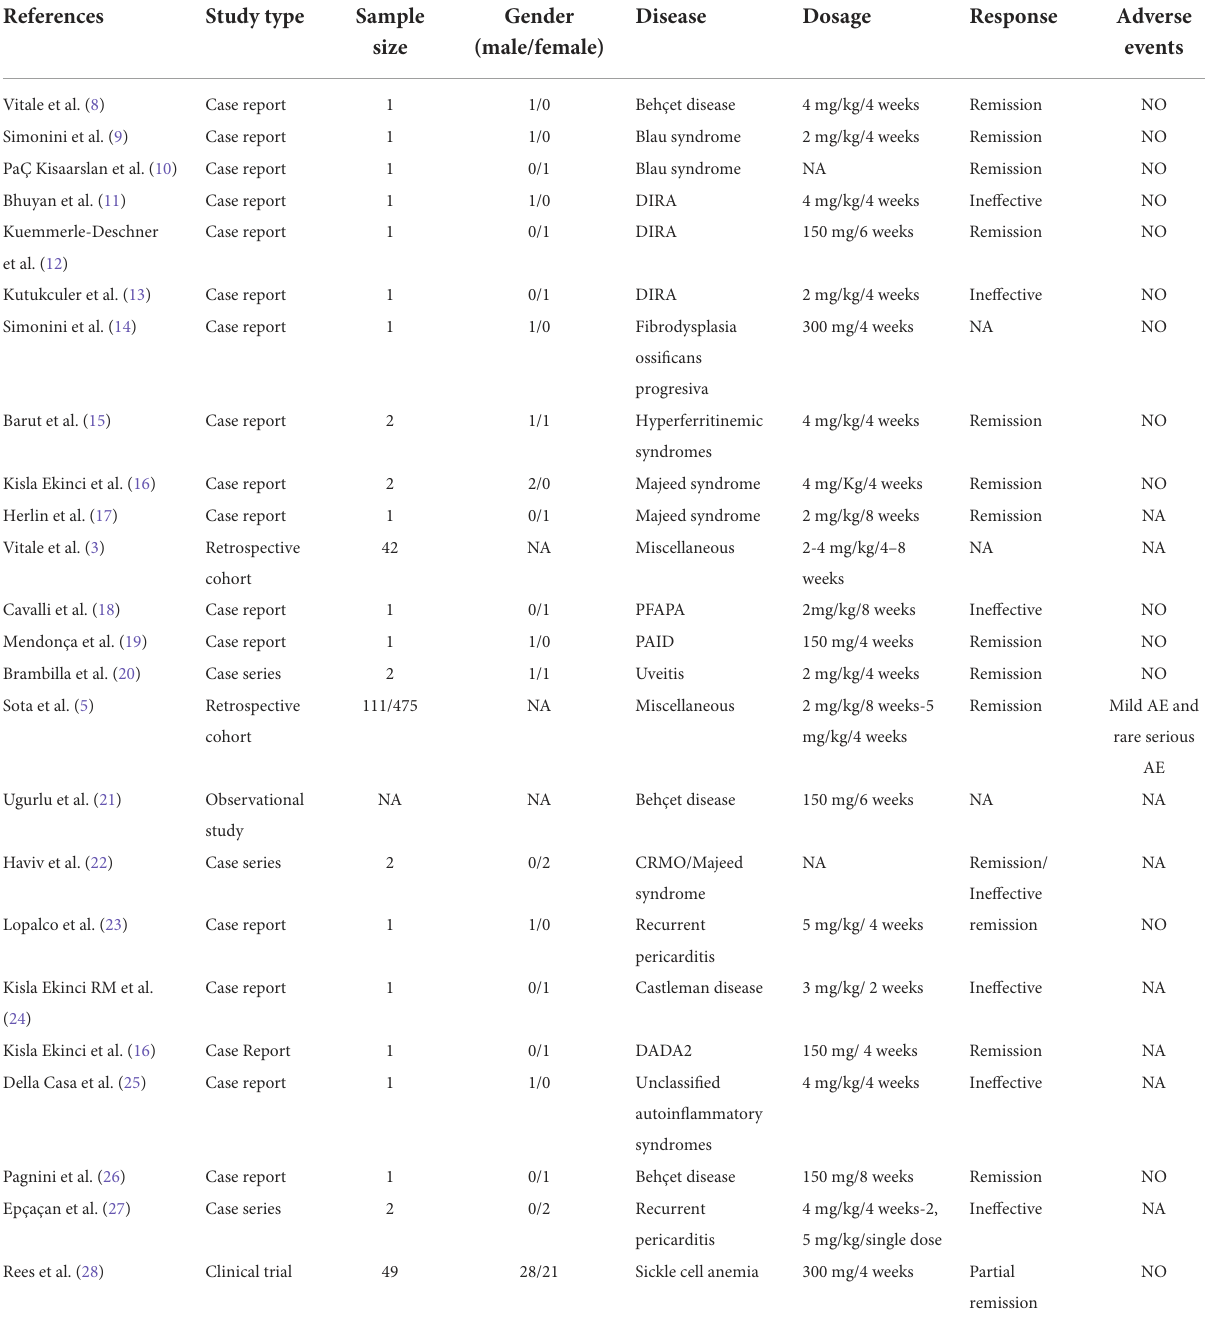
TABLE 1 Data regarding off-label use of canakinumab in pediatric patients with the immune-mediated disorder from the individual studies